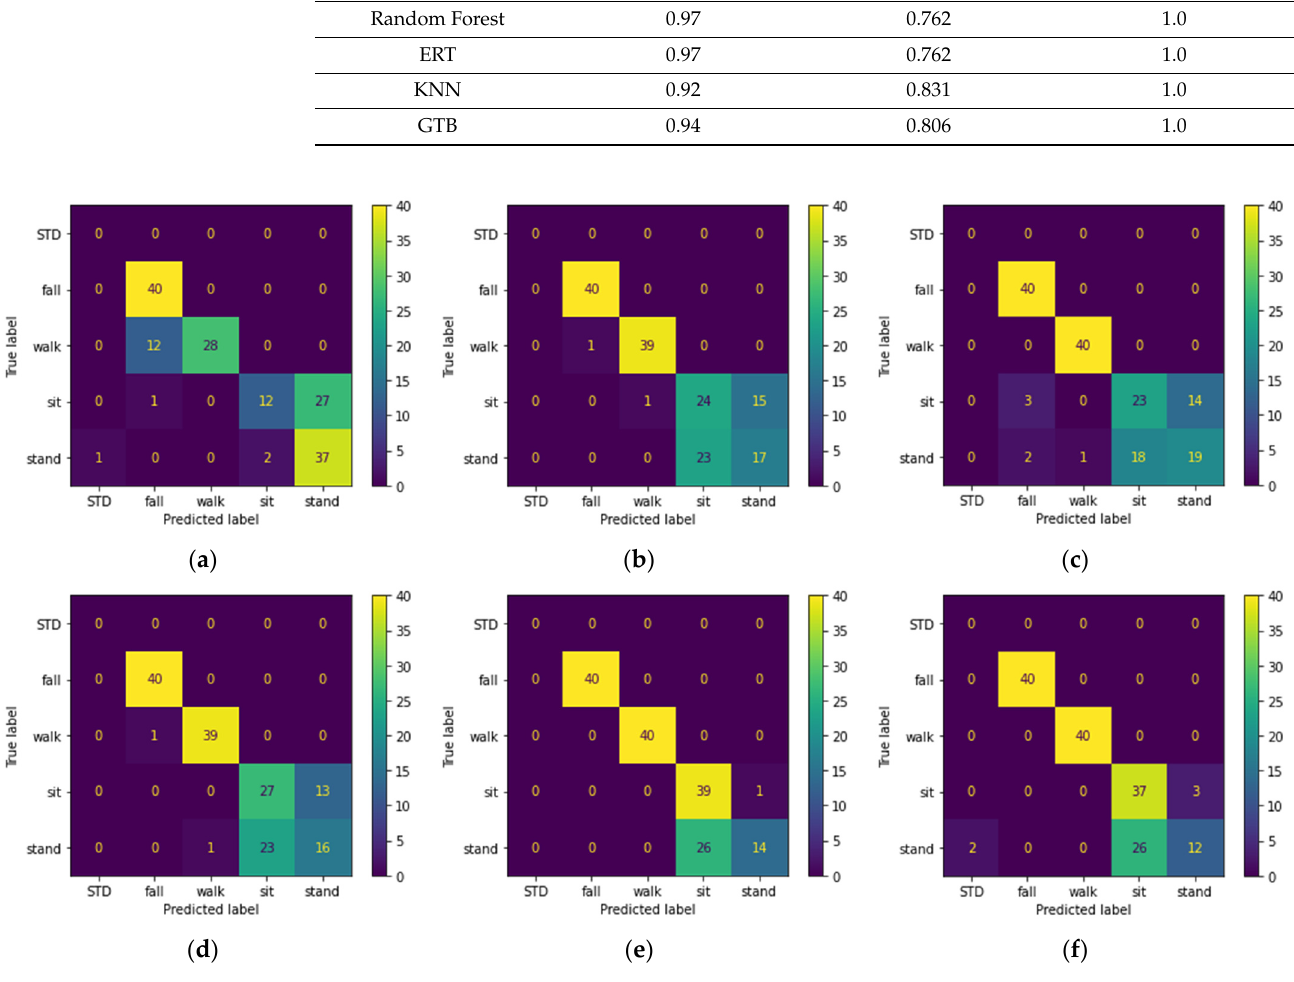
Figure 6. Confusion matrix of the activities in the unseen dataset predicted using: ( a ) MLP; ( b ) SVM; ( c ) Random Forest; ( d ) ERT; ( e ) KNN; ( f ) GTB; classifiers trained with top PCA components extracted from Mel-spectrogram features of the train dataset.